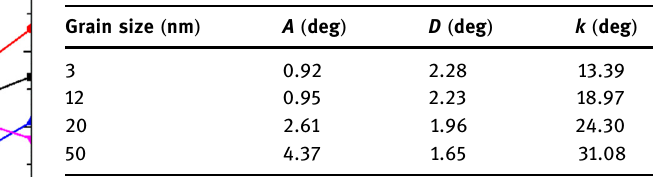
Table 4: Grain rotation results for di ff erent grain sizes